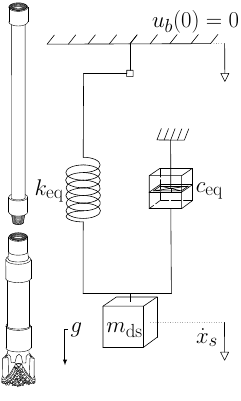
Figure 3: The rig and DS